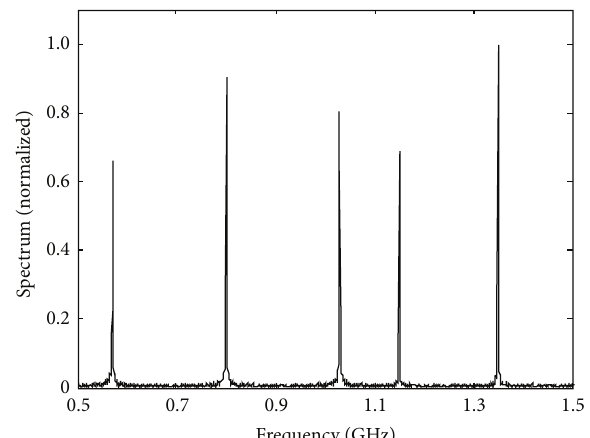
Figure 3: Frequency estimated results, 𝑁 𝐿 = 4096 and SNR = 15dB.